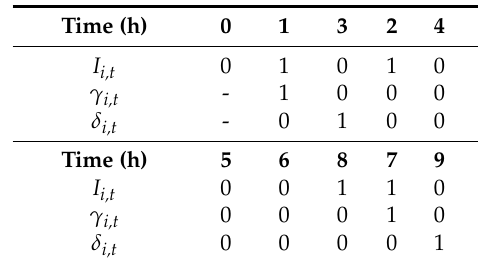
Table 1. The relation between units’ states, ON states and OFF